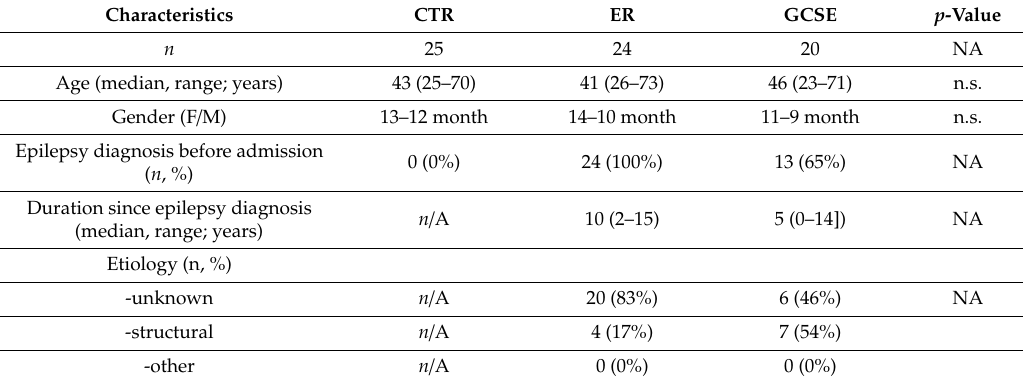
Table 1. Study groups characteristics.